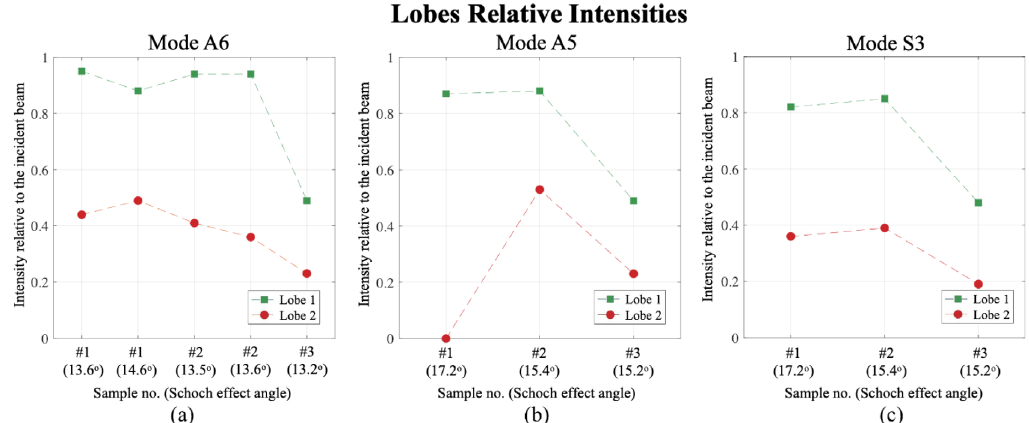
Figure 8. Relative intensities (ratio of the intensity of a lobe to that of the incident beam) for modes A6, A5, and